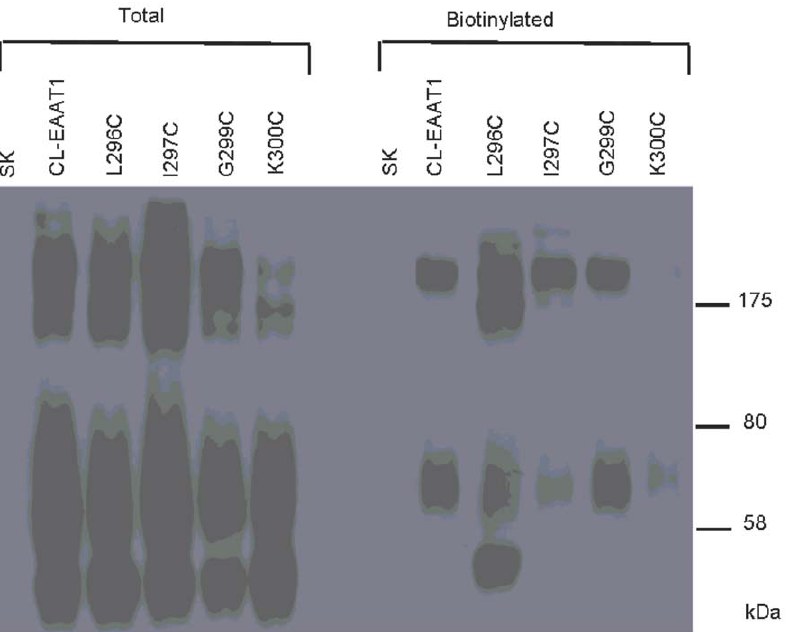
Figure 4. Cell surface biotinylation of Cysteine-less EAAT1 and mutants. HeLa cells, expressing Cysteine-less EAAT1 and the four indicated mutants, as well as HeLa cells transfected with the vector alone (SK), were biotinylated and processed as described in the Materials and Methods. The six left lanes show the total samples, and the six right lanes show the biotinylated samples. All samples were separated on the same SDS gel, transferred to nitrocellulose, and probed with the antibody to EAAT1. The positions of the molecular mass standards (in kDa) are indicated on the right . The experiment was repeated three times and a similar result was obtained. The result is representative of three independent experiments.